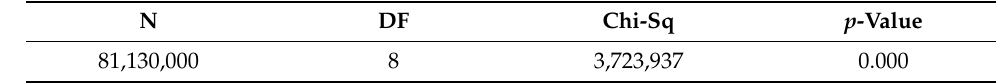
Figure 12. Observed vs. expected specific energy absorption values.